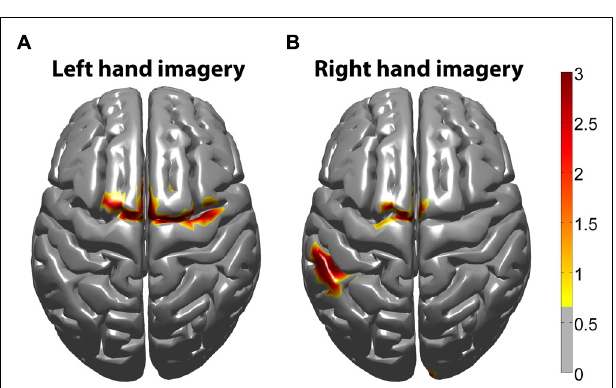
FIGURE 13 | Z -score group average fMRI BOLD maps of all subjects ( n = 10). fMRI BOLD activity was averaged from all subjects in standard MNI space. (A) Averaged fMRI BOLD activity during left hand motor imagery. (B) Averaged fMRI BOLD activity during right hand motor imagery.The threshold was determined from a mixed effect model, correcting for multiple comparisons at the group level, using a Gaussian weighted cluster correction at p <